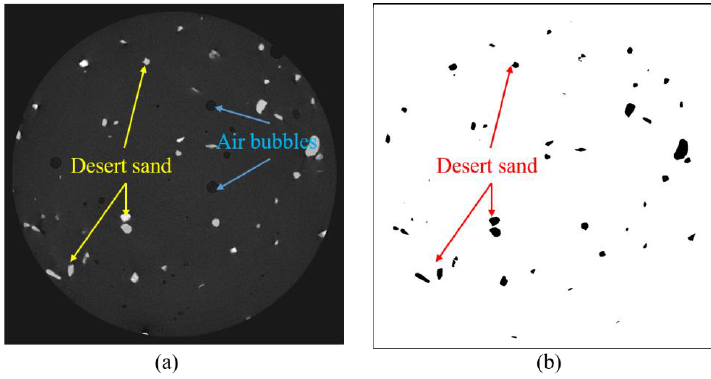
Figure 1. Processing of CT slice: ( a ) original slice; ( b ) segmented slice.